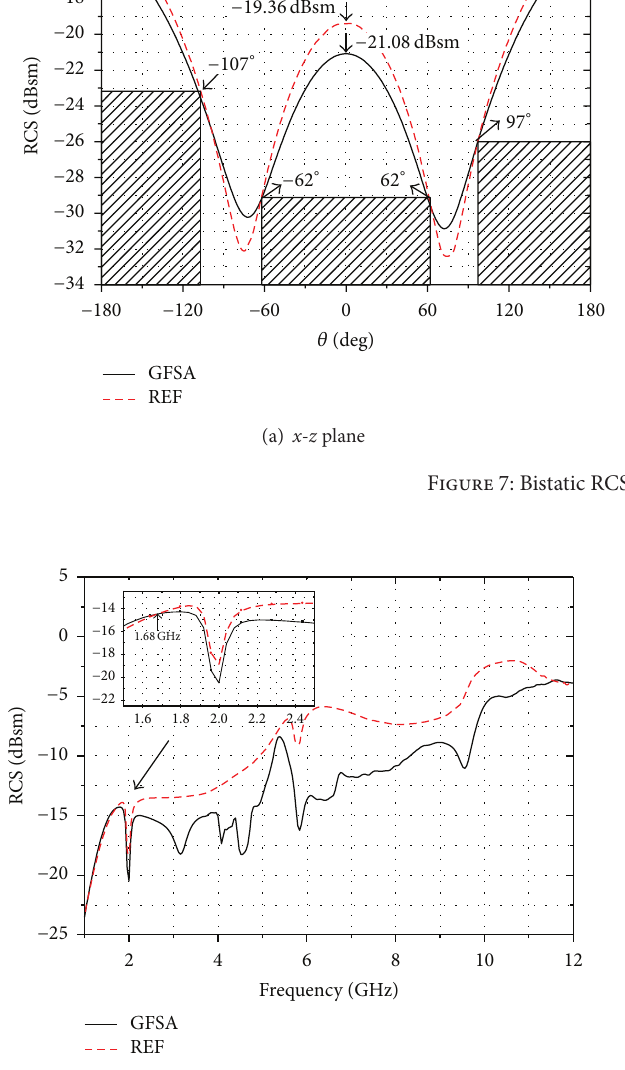
Figure 8: Bistatic RCS with incident frequency.